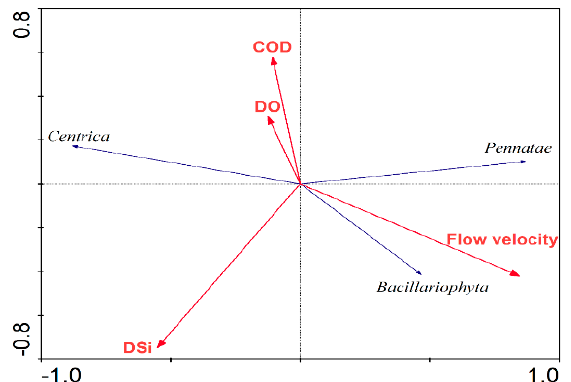
Figure 8. Biplot diagrams for the RDA of the relationship between diatom composition and environmental variables.